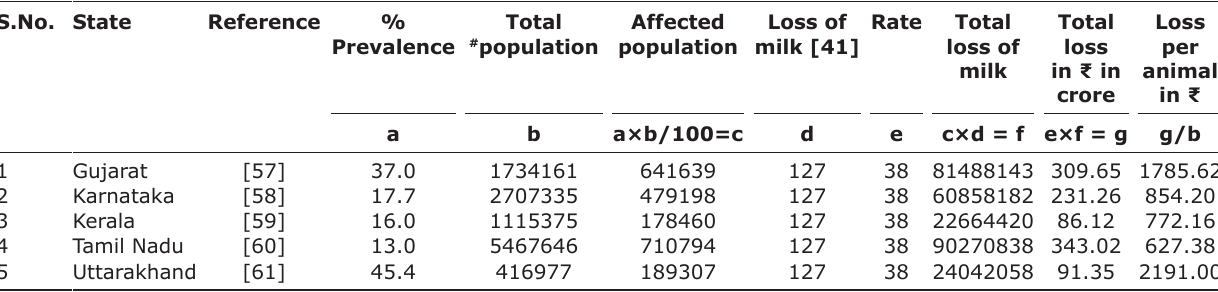
Table-5: Projected economic losses due to theileriosis in CB cattle in five states of India S.No.